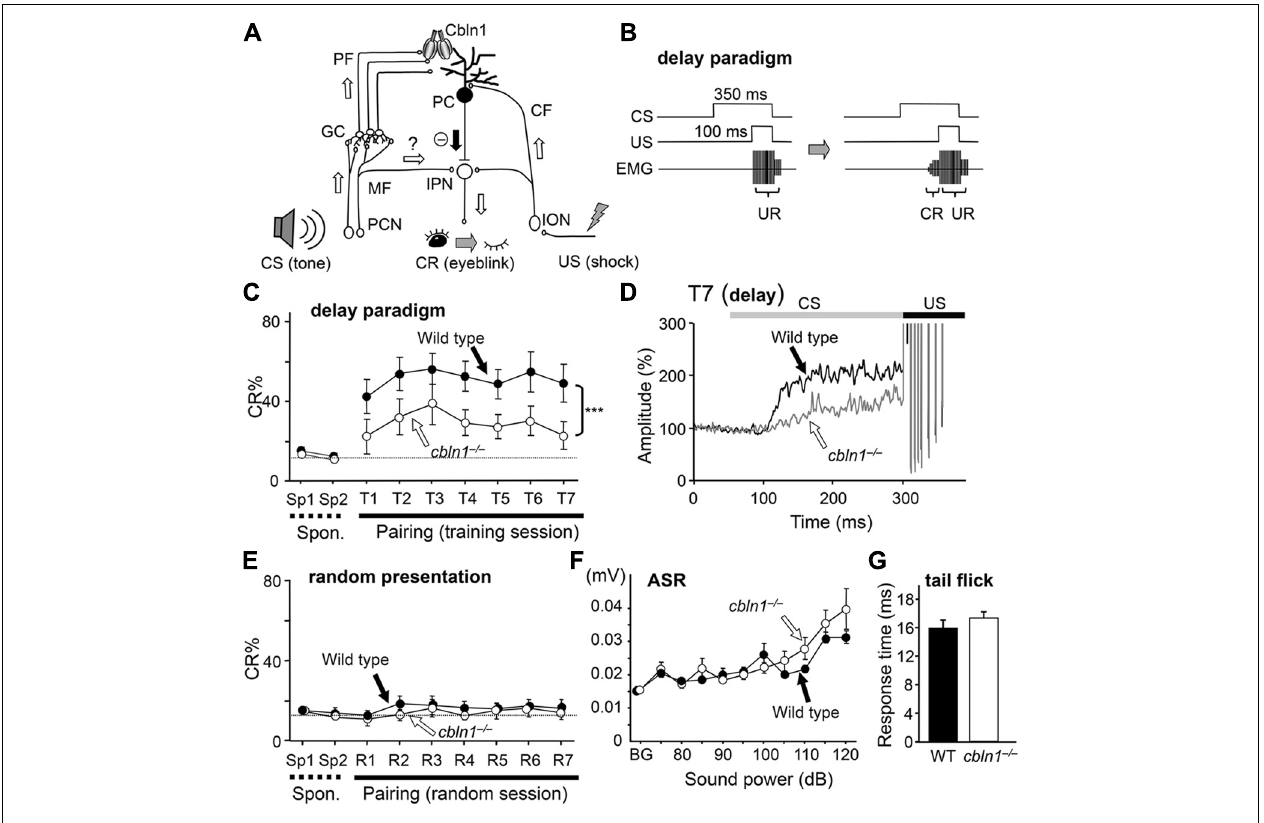
FIGURE 1 | Delay eyeblink conditioning (EBC) is impaired in cbln1 − / − mice. ( A ) A diagram showing the cerebellar circuits responsible for